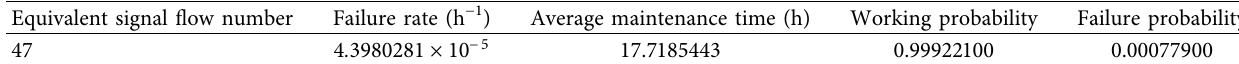
Table 11: Reliability parameters of operator 47.